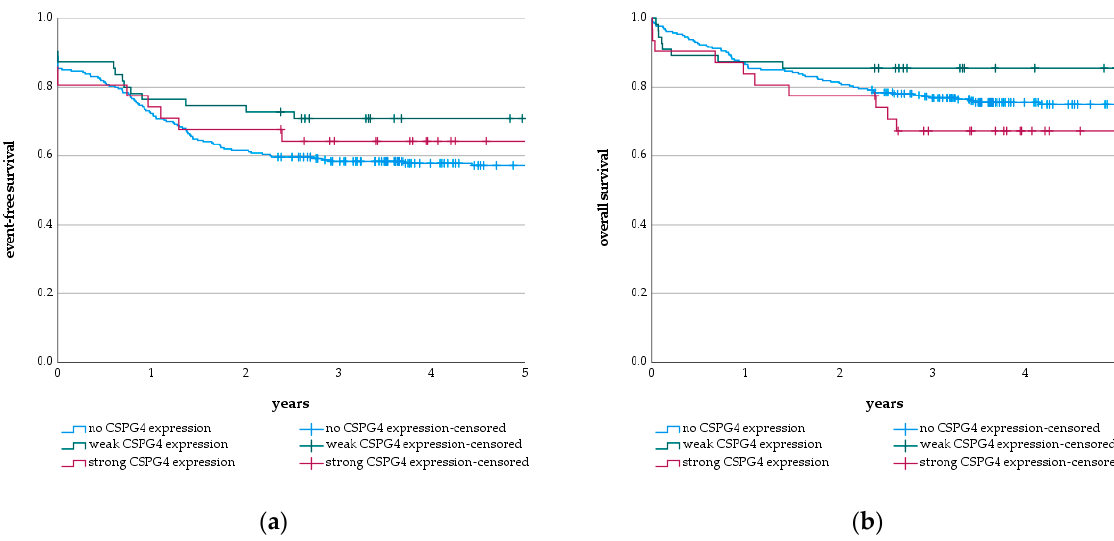
Figure 5. Survival of pediatric AML patients depending on CSPG4 expression level. ( a ) 5-year event-free survival (EFS) of pediatric AML patients without CSPG4 expression (57.2% ± 3.1%), with weak CSPG4 expression level (70.9% ± 6.1%) and with strong CSPG4 expression level (64.4% ± 8.6%) ( p = 0. 204); ( b ) 5-year overall survival (OS) of pediatric AML patients without CSPG4 expression (74.9% ± 2.7%), with weak CSPG4 expression level (85.5%±4.8%) and with strong CSPG4 expression level (67.3% ± 8.5%) ( p = 0.161). Significance was calculated with log-rank test.